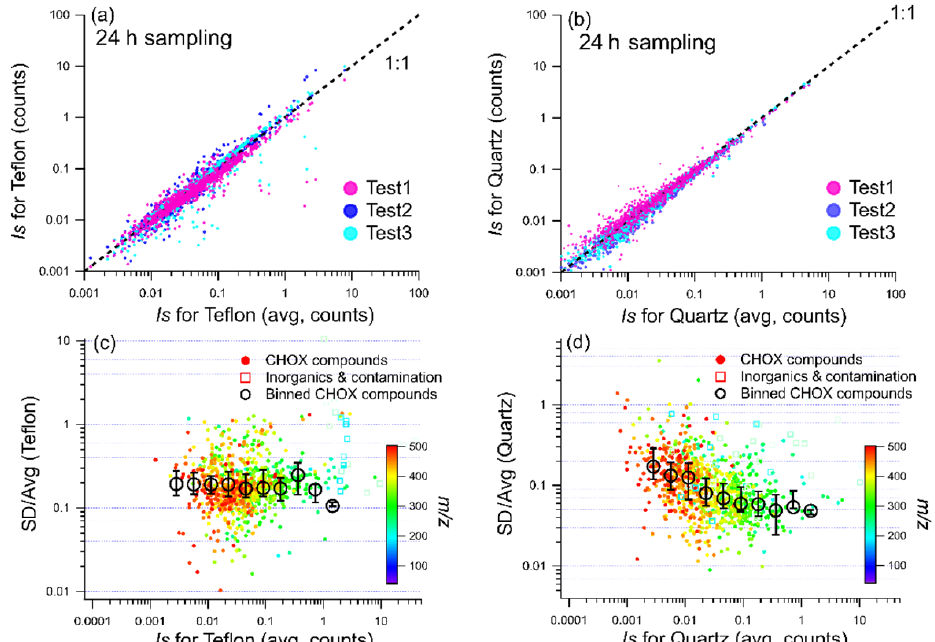
Figure 4. Comparison of the integrated signals from duplicate tests of the same 24h sample for (a) Teflon and (b) quartz fiber filters. The relative error (Is ratio of standard deviation/average) value of the three duplicate tests as a function of Is for (c) Teflon and (d) quartz filters. In panels (c) and (d) , CHOX compounds are shown as dots, and inorganics and contaminants are shown as squares colored by the m/z . The black circles in panels (c) and (d) represent median values of signal intensity bins (with log Is intervals of 0.3 for the Is range of 0 to 2), and error bars represent the 25th and 75th percentile of binned values of SD(Is) / Avg(Is) for CHOX.